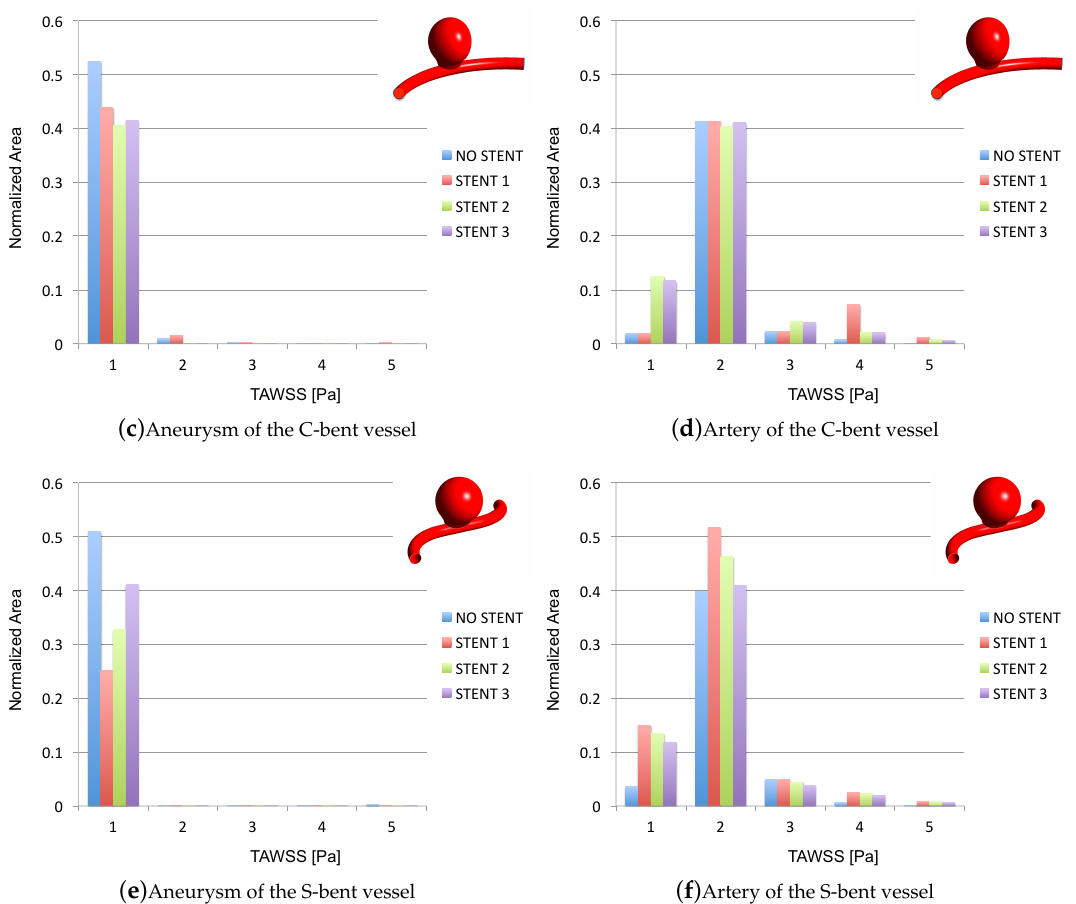
Figure 6. Histograms of the normalized area associated to the TAWSS of the aneurysm and of the artery (and stent) for V-bent, C-bent and S-bent vessel configurations. The depicted areas are normalized with respect to the area of whole geometry